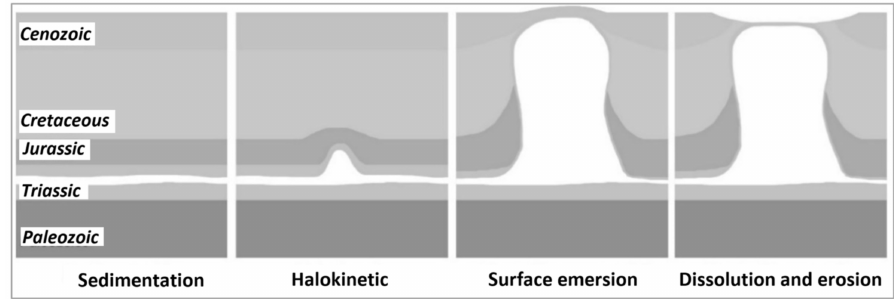
Figure 5. Salt diapir formation